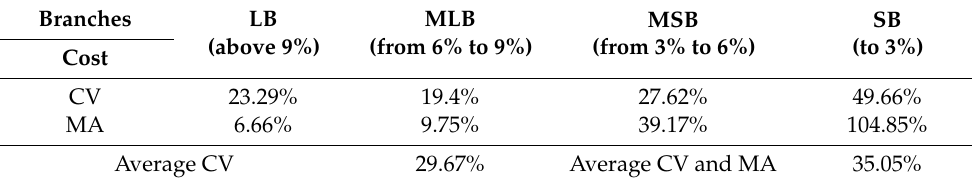
Table 4. The analysis of the branches of SRK S.A. as a one group.